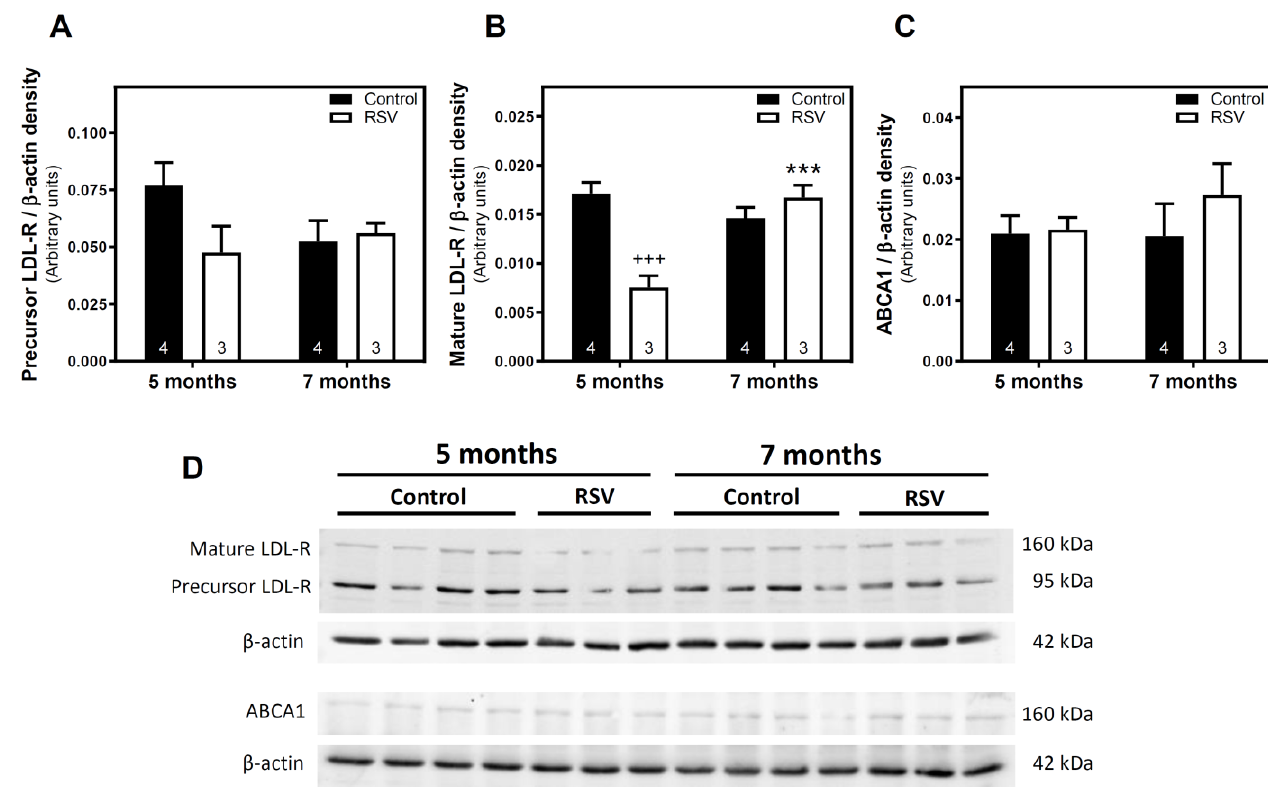
Figure 2. Analysis of proteins involved in cholesterol uptake and release in the brain of SAMP8 mice. Cholesterol import-related receptors such as LDL-R precursor ( A ) and its mature form ( B ) together with ABCA1 ( C ) cholesterol release transporter were detected and quantified in the plasma membrane fraction by the Western blotting method ( D ). β -actin was used as a gel loading control. Data are the mean ± SEM of the indicated different samples. Two-way ANOVA and a Sidak test for multiple comparisons were applied. *** p < 0.001: significantly different from the corresponding 5 mo value; +++ p < 0.001: significantly different from the corresponding control group.